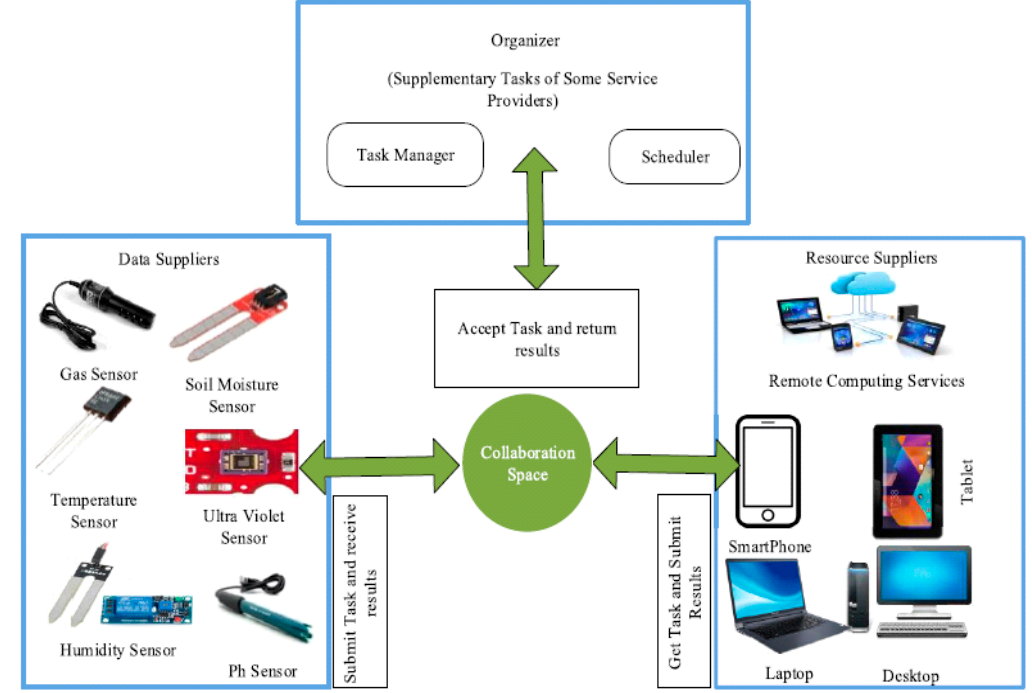
Figure 15. Block diagram of IoT-based smart farming solutions. Reprinted from ref. [162].